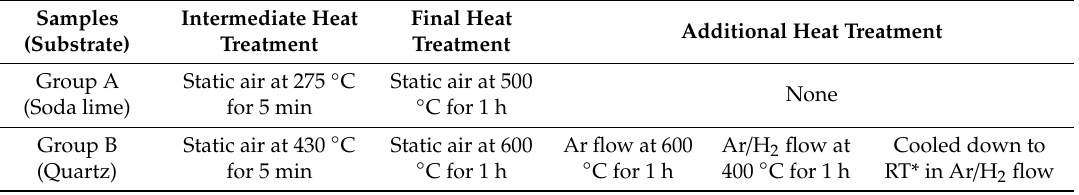
Table 1. The thermal treatment details and thermal history of the